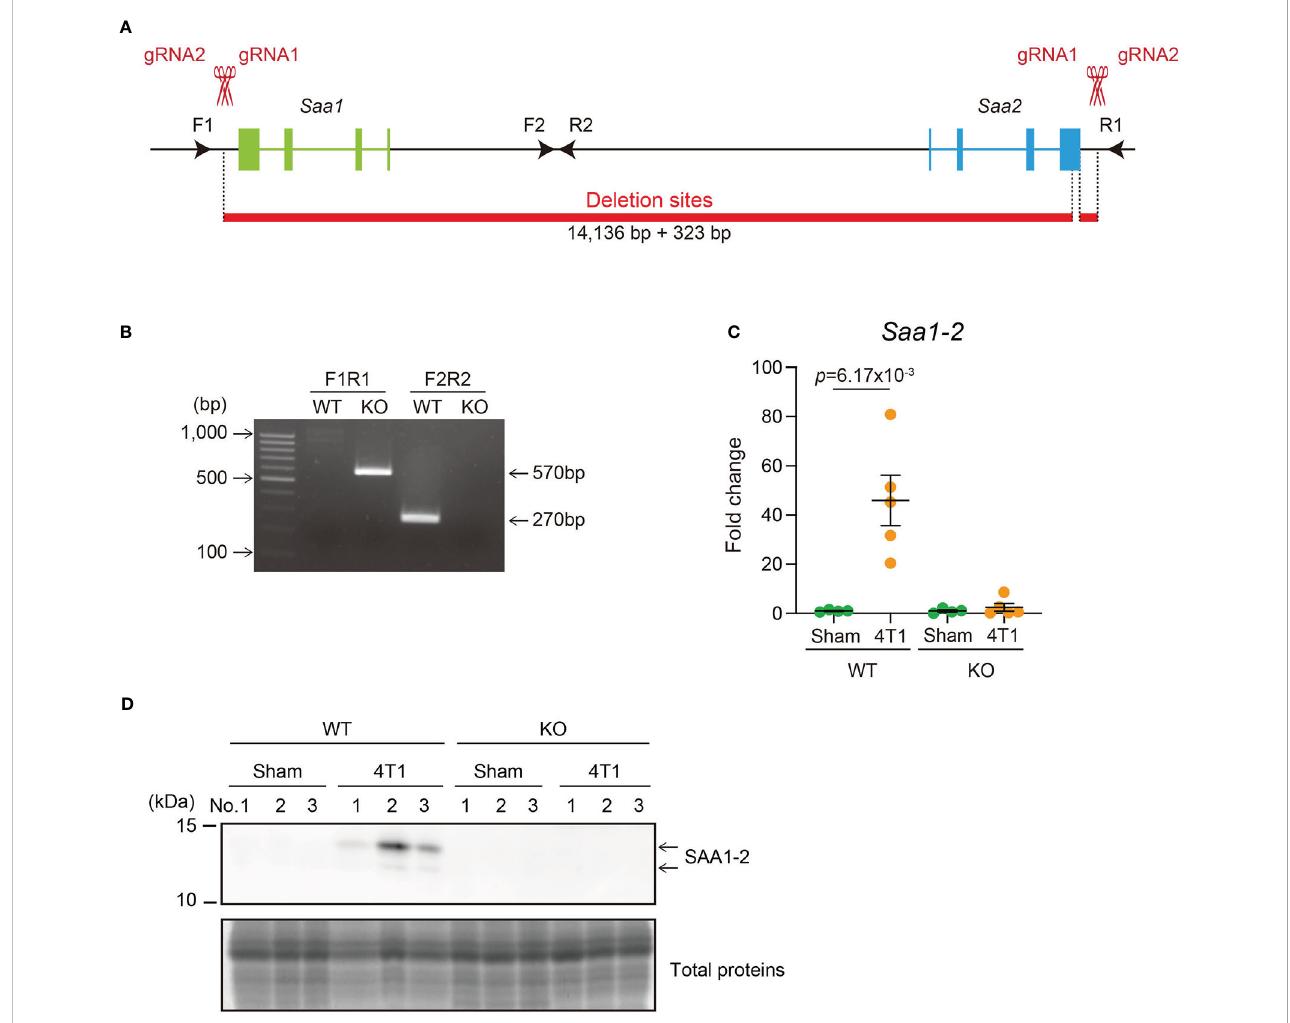
FIGURE 2 Generation of mice completely lacking SAA1-2 (A) Schematic representation of Saa1-2 deletion using the CRISPR-Cas9 system. The gRNA-targeted sites and the primers used for genotyping experiments in (B) are indicated. The deleted regions are indicated in red. (B) A representative image of genomic PCR against the Saa1-2 locus. (C) qPCR analysis of Saa1-2 in the livers of sham and 4T1-bearing mice in WT and Saa1-2 KO. Averaged fold change data normalized to the sham group in each genotype are presented as the mean ± SEM. The p value is shown (unpaired two-tailed Student ’ s t -test). n = 4 for sham-operated mice and n = 5 for the 4T1-bearing mice. (D) Western blot analysis for SAA1-2 in the livers of sham and 4T1-bearing mice in WT and Saa1-2 KO. n = 3. See also Figure